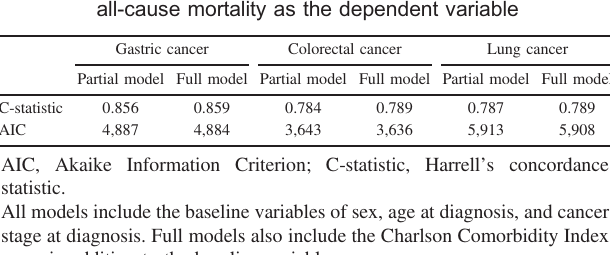
Table 2. Distribution of the Charlson Comorbidity Index score